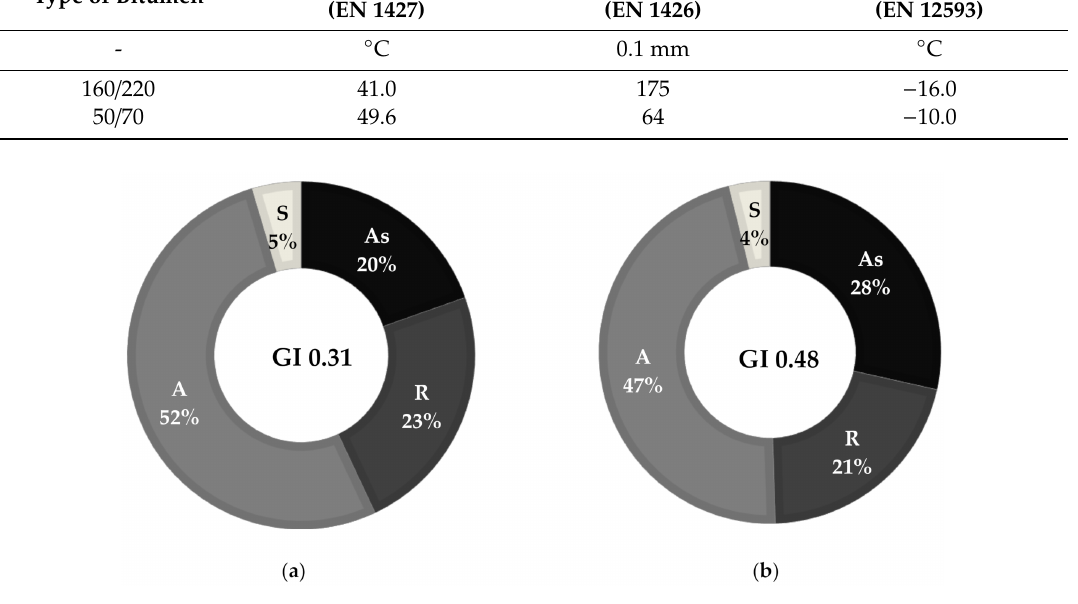
Figure 1. Chemical composition (SARA fractions: S—saturates, A—aromatics, R—resins, As—asphaltenes) and Gaestel Index of bitumens: 160 / 220 ( a ); and 50 / 70 ( b ).